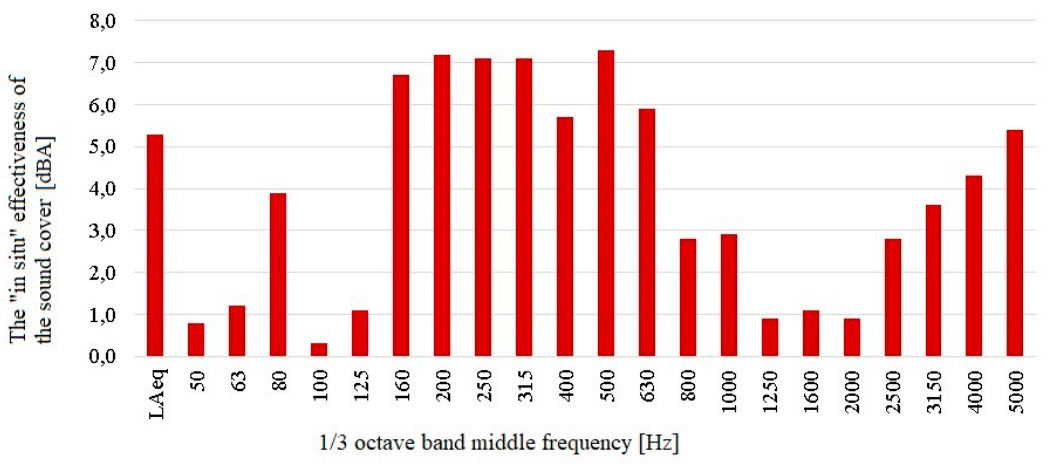
Figure 13. The “in situ” acoustic effectiveness of the prototype sound cover of the expansion joint device.